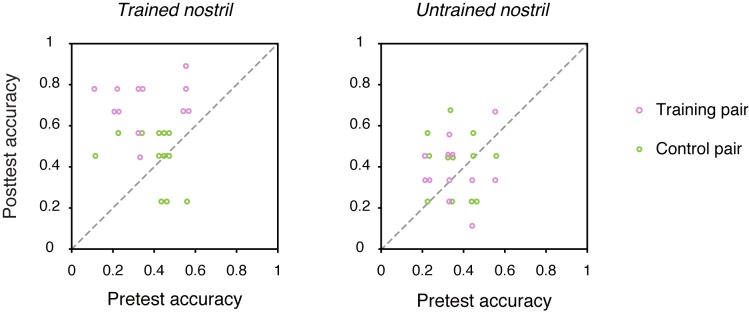
Chiral discrimination accuracies at pretest and posttest for each pair of odor enantiomers presented to the trained vs. untrained nostril for individual participants in Experiment 1.